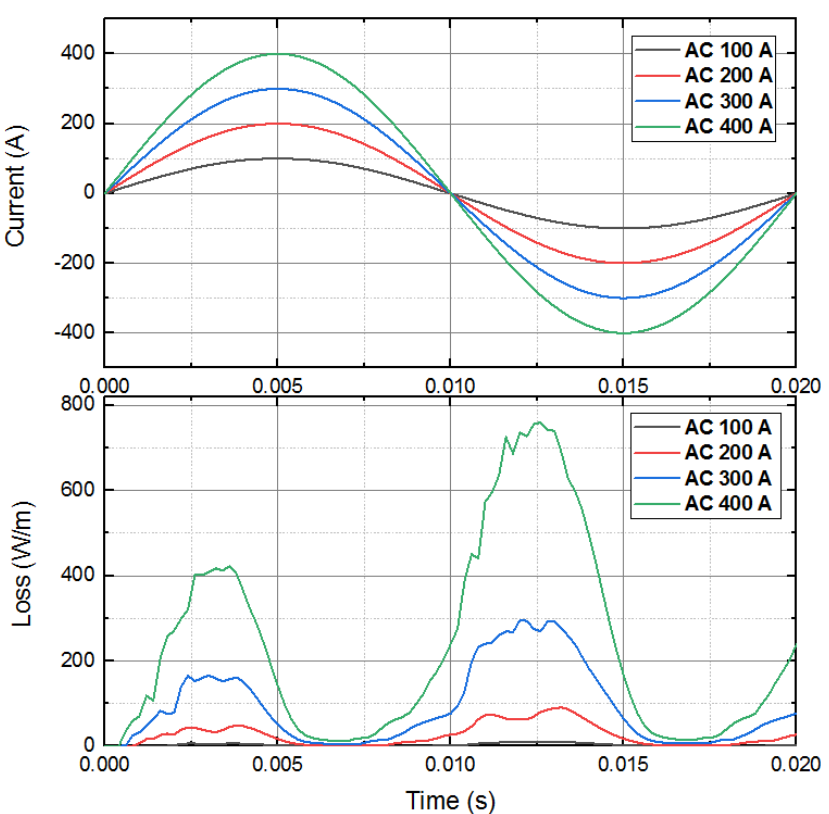
Figure 9. Losses in the HTS magnet with pure 50 Hz AC sinusoidal currents of 100, 200, 300, and 400 A (peak).